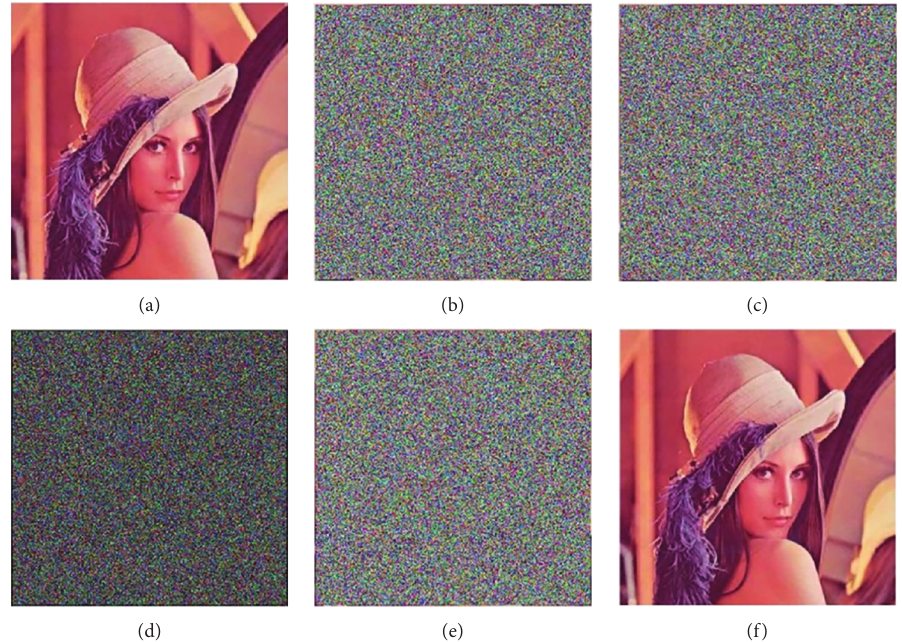
1 ), (c) incorrectly encrypted image ( E 2 ), (d) difference of